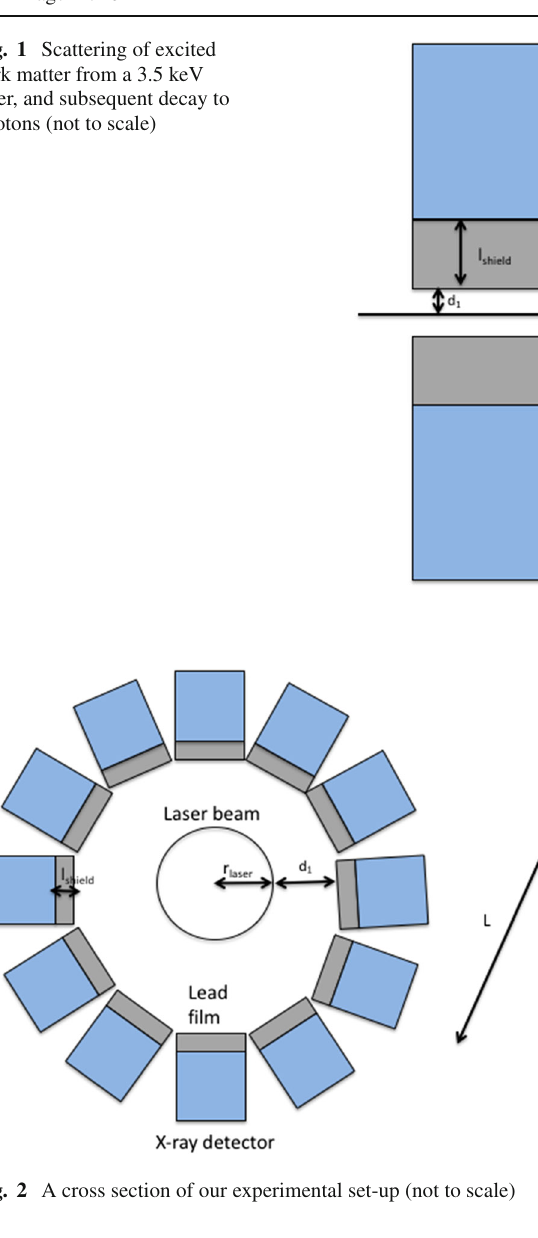
the beam line. (Inelastic scattering of the laser is not prob- lematic, as we can reject any photon detections with energies outside E 0 ± Δ E line .) To overcome this background, we add a “light shining through a wall” component to our